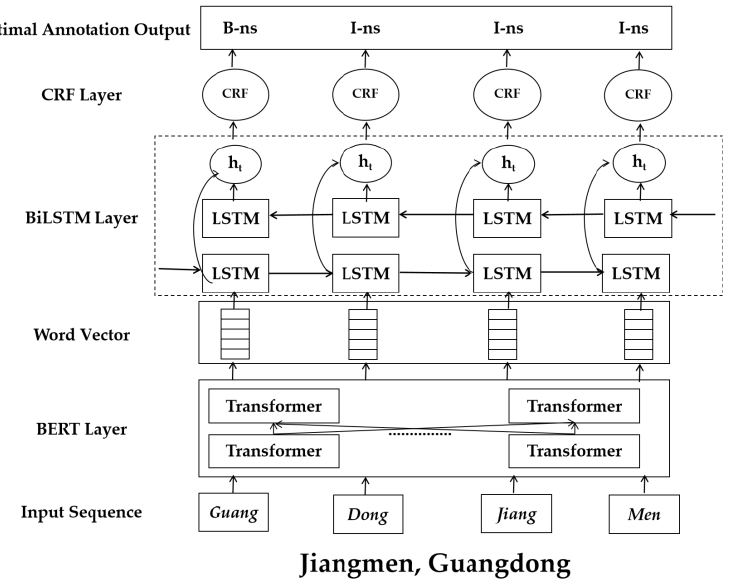
Figure 4. Structure of BERT-BilSTM-CRF